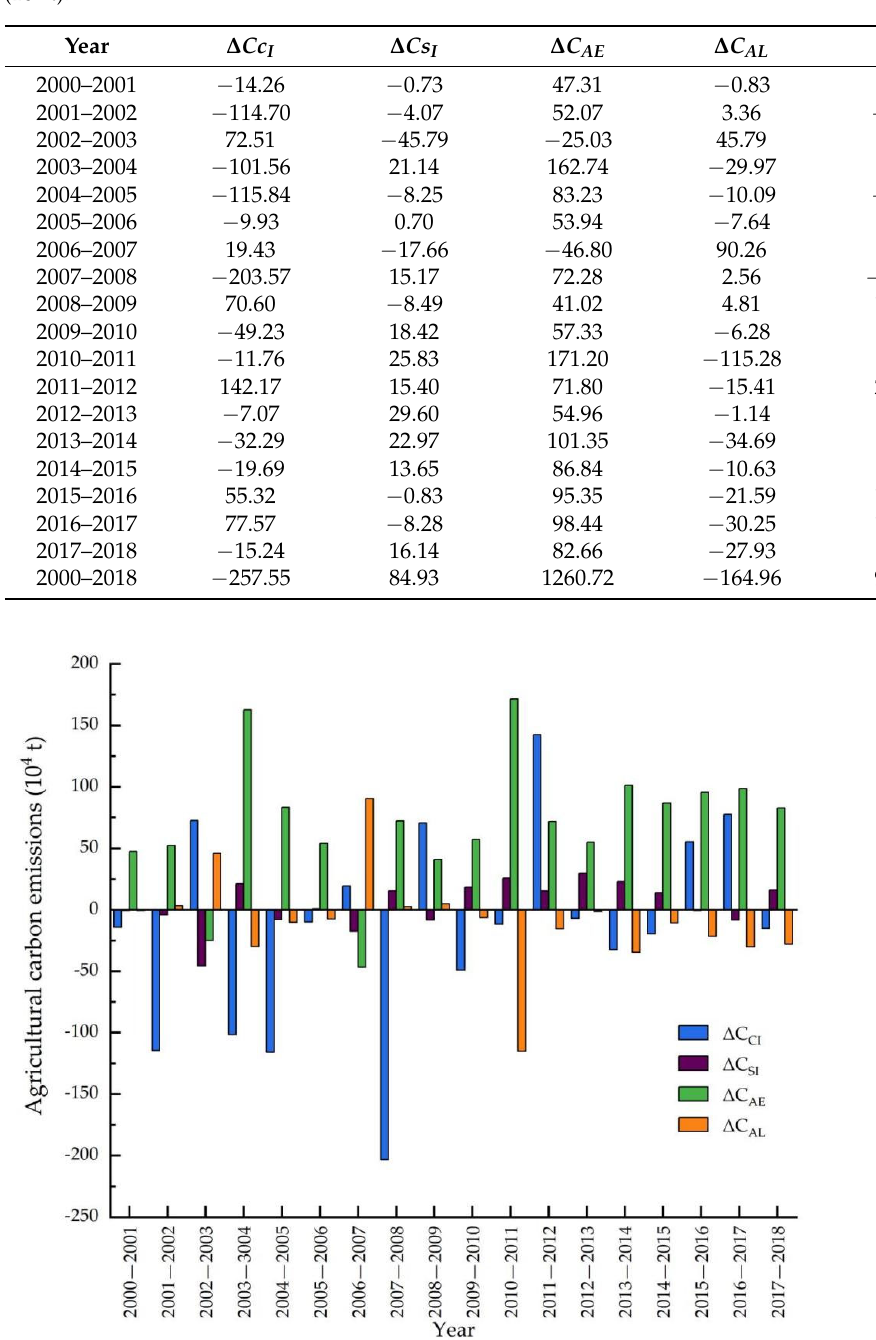
Table 6. Decomposition of agricultural carbon emissions in Heilongjiang province during 2000–2018